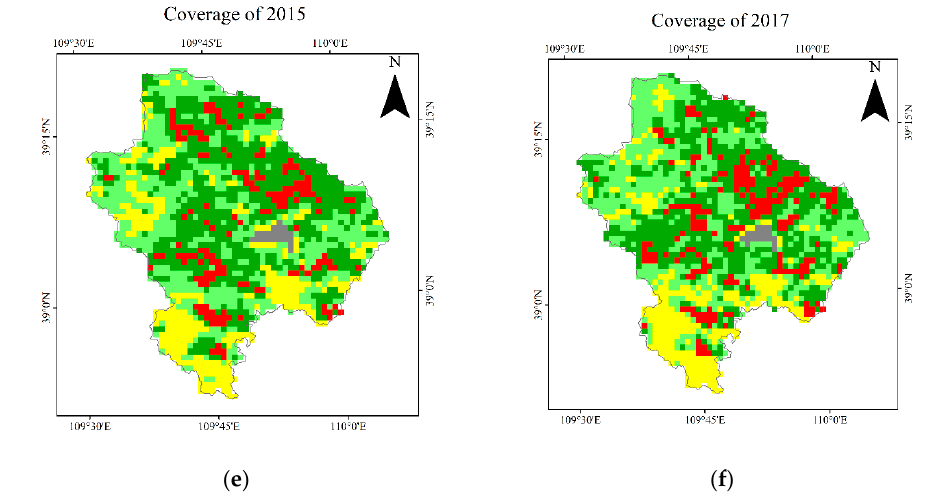
Figure 5. Spatial distribution and change in VC in the HJN watershed from 2000 to 2017. ( a ) is the spatial distribution and VC in the HJN watershed in 2000; ( b ) is the spatial distribution and VC in the HJN watershed in 2005; ( c ) is the spatial distribution and VC in the HJN watershed in 2008; ( d ) is the spatial distribution and VC in the HJN watershed in 2010; ( e ) is the spatial distribution and VC in the HJN watershed in 2015; ( f ) is the spatial distribution and VC in the HJN watershed in 2017.